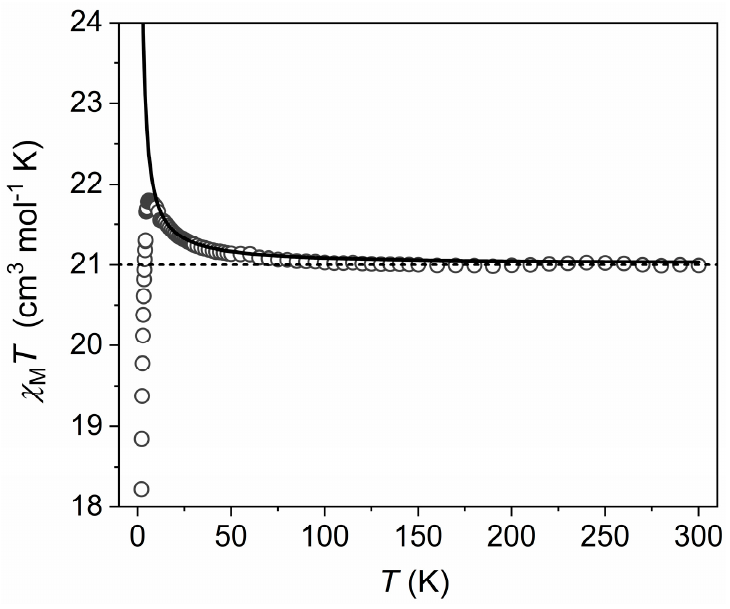
Figure 4. Plot of χ M T (open circles) versus T for complex ( 1 ), with the sum of the Curie constants of the uncorrelated ions and the best-fit data represented by the dashed and solid lines, respectively.